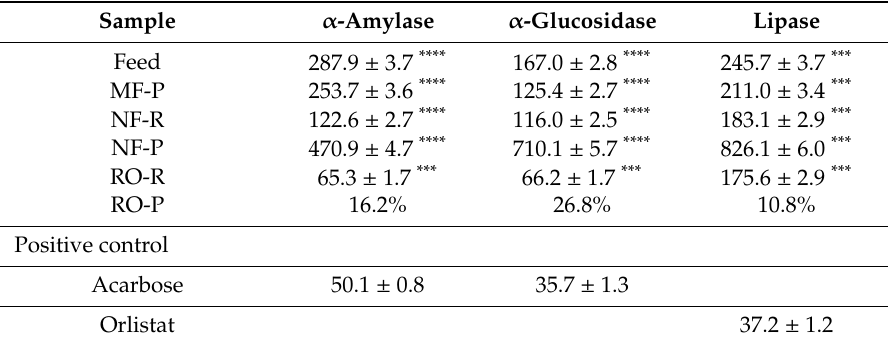
Table 2. Hypoglycaemic and hypolipidemic activity [IC 50 value ( µ g / mL)].